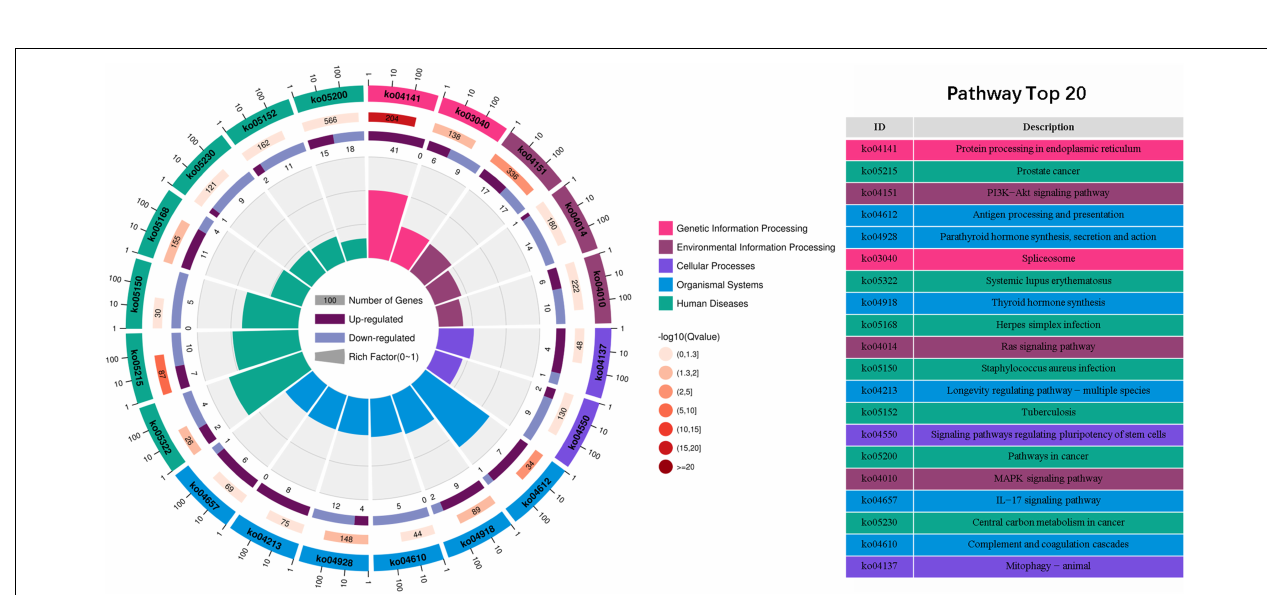
FIGURE 3 | Circular map of the top 20 gene ontology (GO) classifications of differentially expressed genes (DEGs) between 48 h_HS and CO groups. The first (outer) circle shows different Ontology: Biological Process (yellow) and Cellular Component (green). The second circle (orange) shows the background gene numbers enriched in each GO term, the higher the number, the longer the bar; the depth of color represents the q -value, the smaller of the q -value, the deeper the color. The third circle represents the number of up-regulated (dark purple) and down-regulated (light purple) DEGs enriched in each GO term. The fourth (inner, white) circle shows the rich factor value of each GO term (the number of DEGs enriched in this GO term divided by all the numbers of background genes enriched in this GO term). In the fourth circle, each grid of the background grid line represents 0.1.